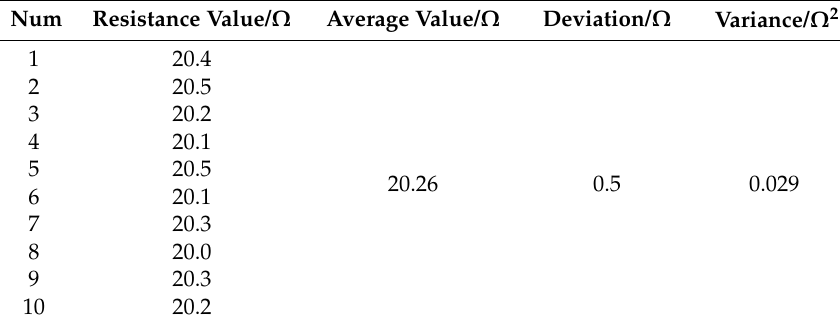
Table 3. The resistance of the new amorphous wire magnetic